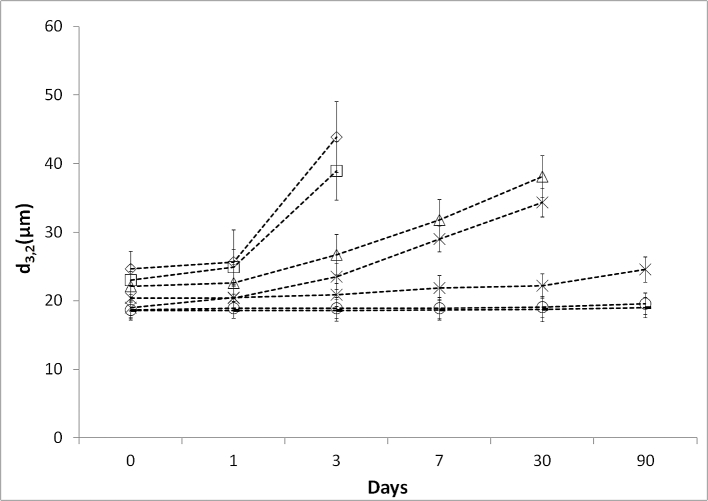
Mean droplet size (d3,2) of complex emulsions (4% w/w) over time prepared with 0% OSA modification (◇); 0.5% OSA-modification (□); 1.0% OSA-modification (△); 1.5% OSA-modification (✕); 2.0% OSA-modification (✱); 2.5% OSA-modification (+) and 3.0% OSA (ˆ). Emulsion droplet size measurements were ceased once coalescence of the more unstable emulsions was observed. Data are means of three replicates ± standard deviation.